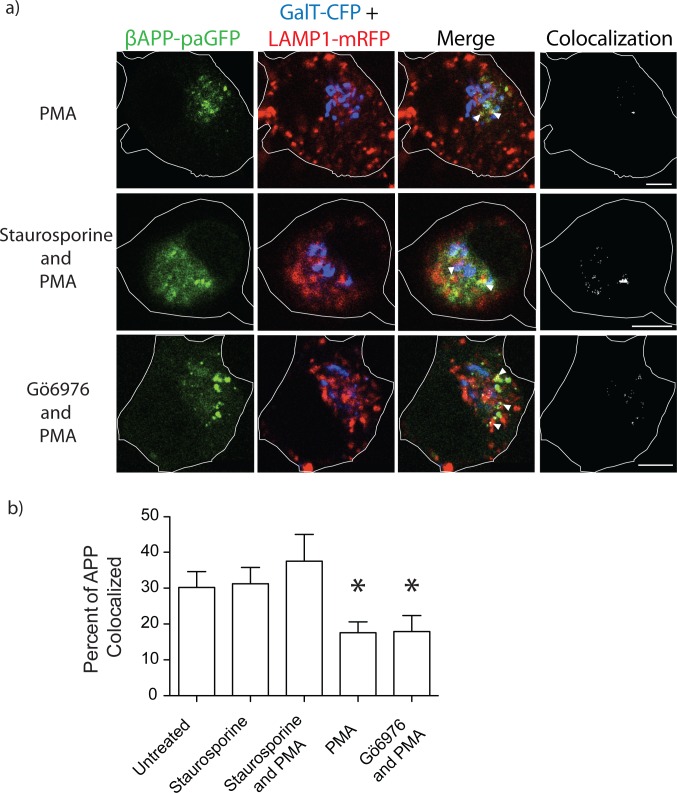
Staurosporine but not Gö6976 treatment restores trafficking of APP to lysosomes.SN56 cells were pretreated for 1 hour with staurosporine or Gö6976 for 1 hour before treatment with PMA. Cells were imaged as previously stated. Depicted in a) are representative images of cells treated with PMA, with or without the indicated inhibitors. These images were taken from live cell video of photo-activated cells 15 minutes after the start of imaging. Far-right panels show colocalized pixels between the βAPP-paGFP and LAMP1-mRFP channels. The edge of the cell is defined by the white line, and was drawn based on the white light images. Triangles point to colocalized pixels. Scale bars represent 5μm for all images. b) The amount of APP colocalized with LAMP-mRFP was quantified using Imaris and plotted using Prism. Error bars represent SEM and * denotes p<0.05 as compared to untreated cells and cells treated with staurosporine and PMA.